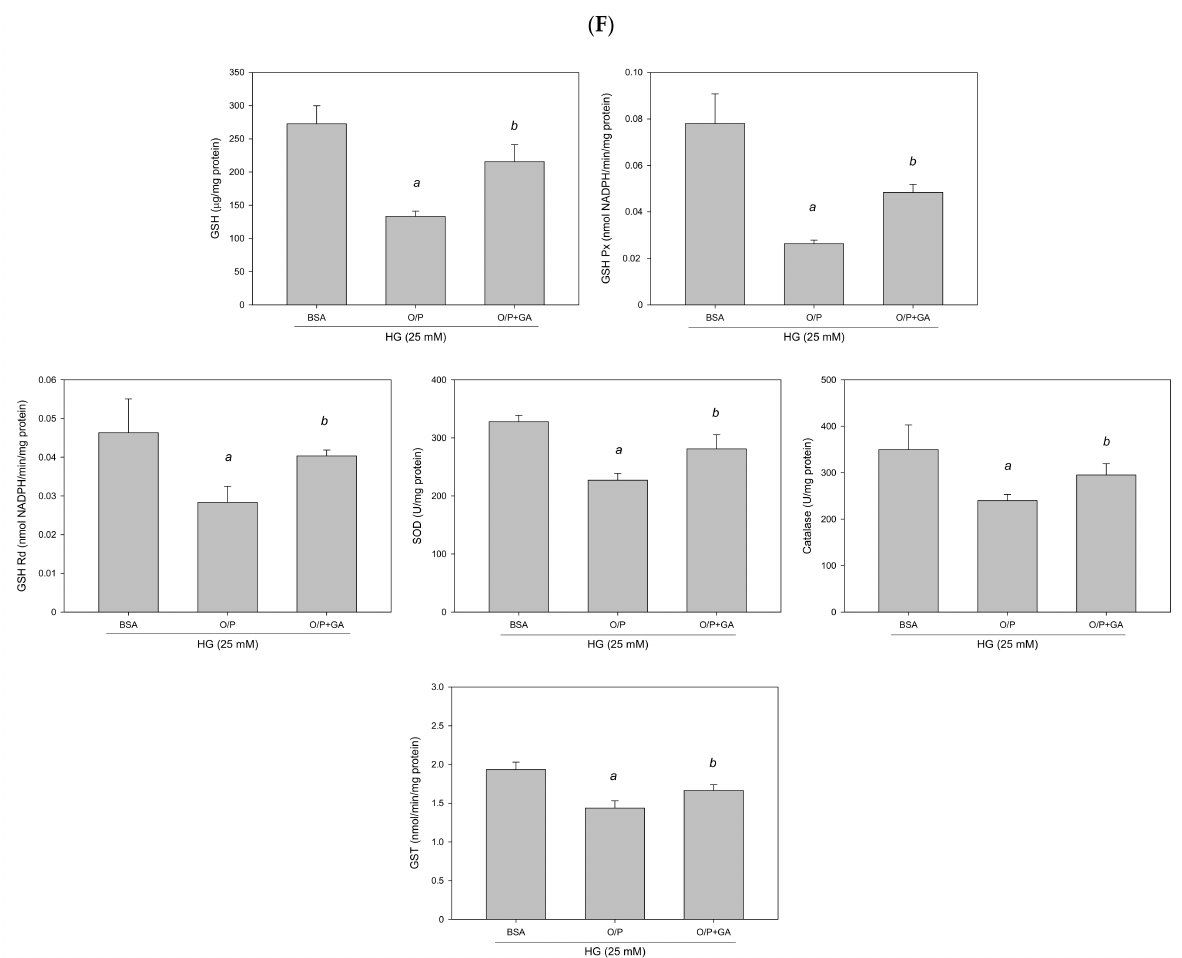
Figure 12. GA-induced reduction in hepatic lipids and lipogenic protein expression is associated with suppression of miR-34a-5p expression in HepG2 cells. HepG2 cells were treated with 10 µ M GA for 24 h in the presence of oleic acid/palmitic acid. ( A ) Oil Red O staining. ( B ) Intracellular triglyceride level. ( C ) Western blotting analysis of NFE2L2, FASN, and SREBP1. ( D ) Real-time PCR analysis of miR-34a-5p expression. ( E ) Luciferase activity. ( F ) Antioxidant enzyme activities. a, p < 0.05 compared with the normal control group (NC or BSA group). b, p < 0.05 compared with the HG + O/P